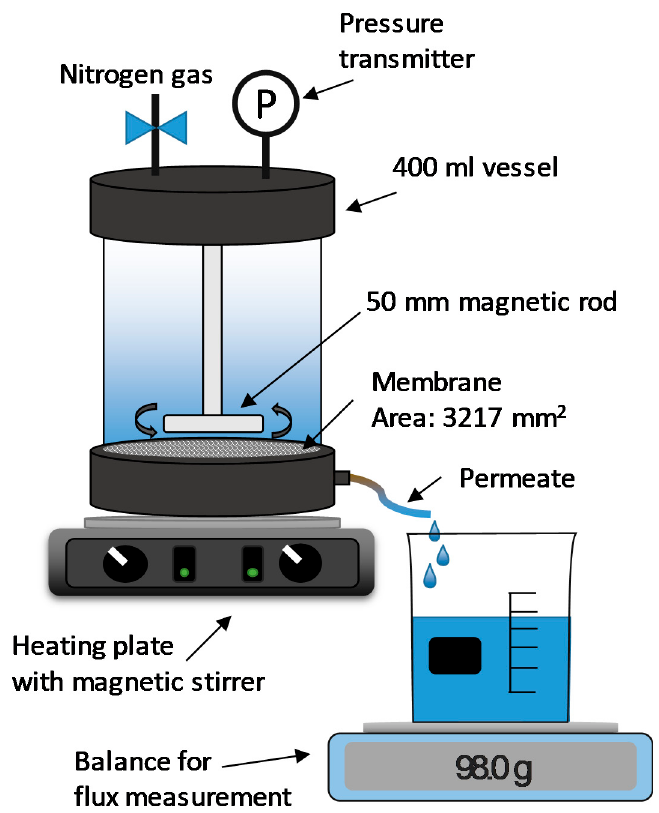
Figure 6. Illustration of the membrane filtration equipment.